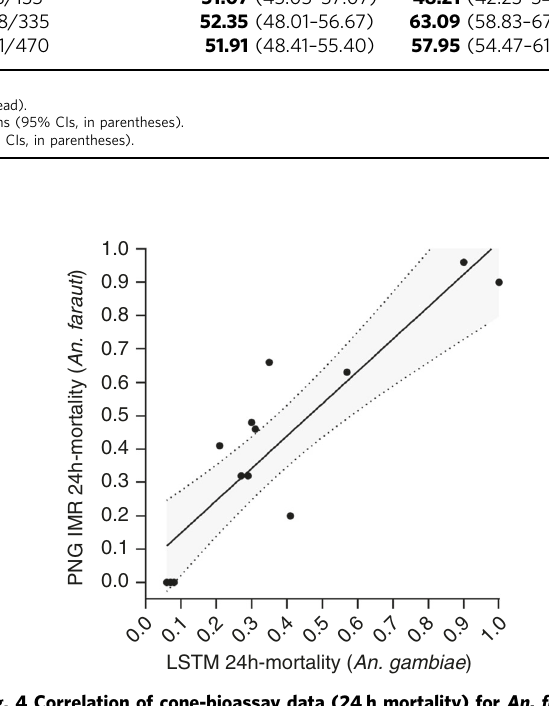
Fig. 4 Correlation of cone-bioassay data (24 h mortality) for An. farauti and An. gambiae G3. Experiments with An. farauti were conducted at PNGIMR and experiments with An. gambiae G3 were conducted at LSTM with using the same LLIN samples ( n = 19). The best fi t curve obtained using standard linear regression analysis is represented by the continuous black line. The grey shading in between the dotted lines represents the 95% con fi dence band of the best fi t curve. Each data point represents one bioassay result conducted on one individual, independent LLIN. If the bioassay was valid (positive and negative control mortality <10%) bioassays on individual LLIN samples were not repeated. Source data for this Figure are provided as a Source Data fi